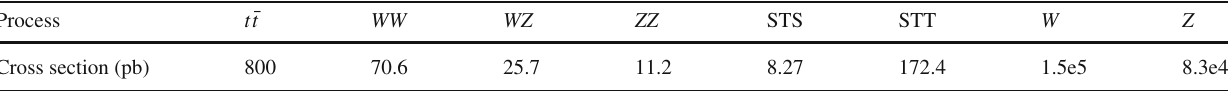
√ s = 14 TeV. “STS” and “STT” denote the single top s and t channels, respectively. The top pair cross Table 3 Background cross sections at